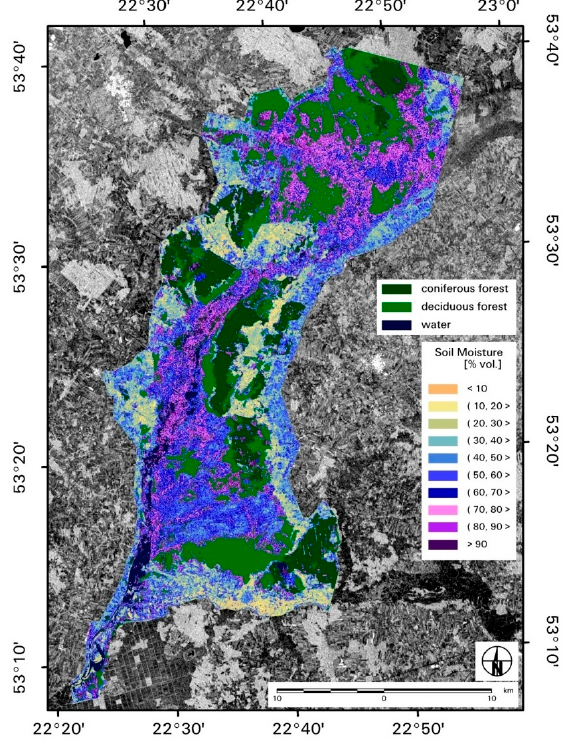
Figure 4. Map of soil moisture based on Sentinel-1 VH data acquired on 10 July 2015.